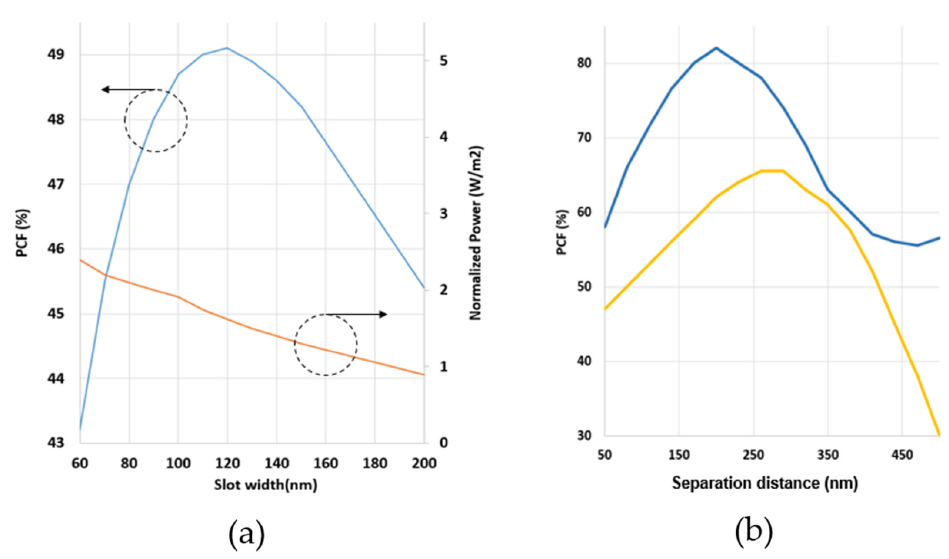
Figure 8. The high expression of norm electric field distribution with 120 nm slot width by assum- ing TE polarization at 3 µm wavelength.